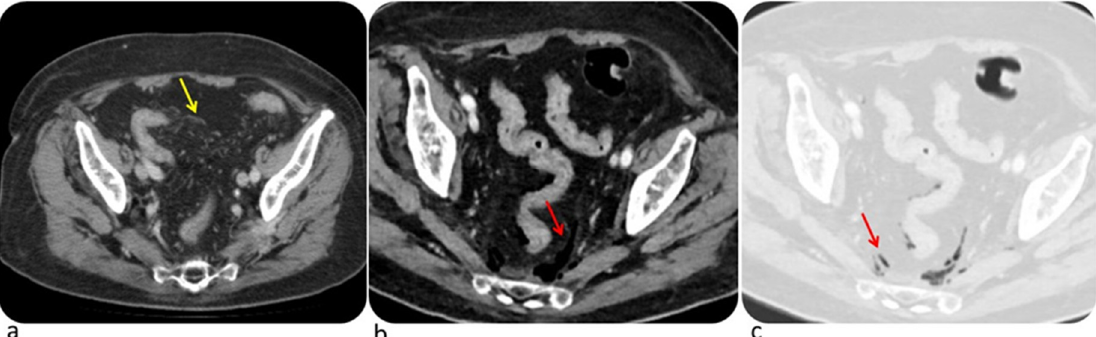
Figure 2. Complicated immune-related colitis in a 54-year-old man with metastatic melanoma treated first with ipilimumab then with Pembrolizumab. CT image shows mesenteric vessel engorgement ( a , yellow arrow); CT performed two months later demonstrates free intraperitoneal air ( b , c , red arrow) due to intestinal perforation. © Department of Radiology, Candiolo Cancer Institute—IRCCS. Turin.